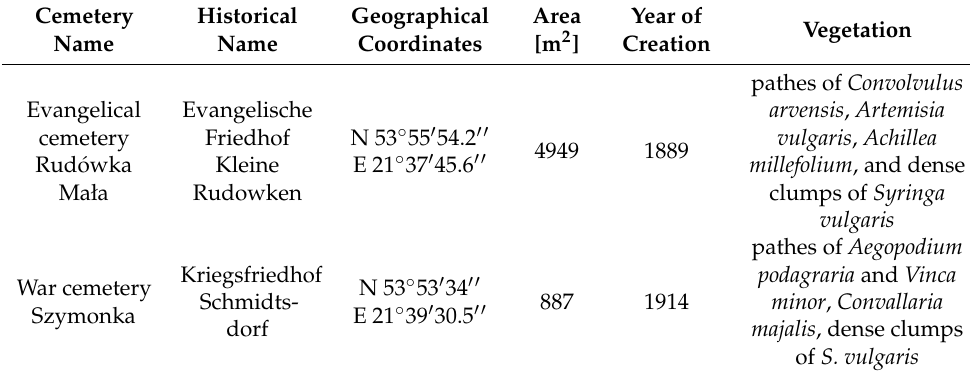
Figure 1. Location of the examined cemeteries against the background of Poland. A: cross section in Rudowka Mala cemetery and B: cross section in Szymonka cemetery. Table 1. General information about the examined cemeteries.